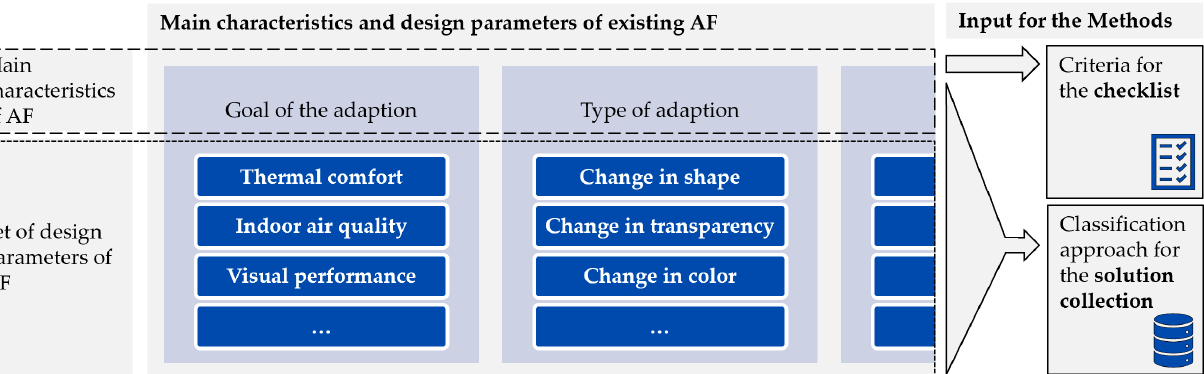
Figure 6. Relationships between the sets of main characteristics and design parameters and the methods to be developed.